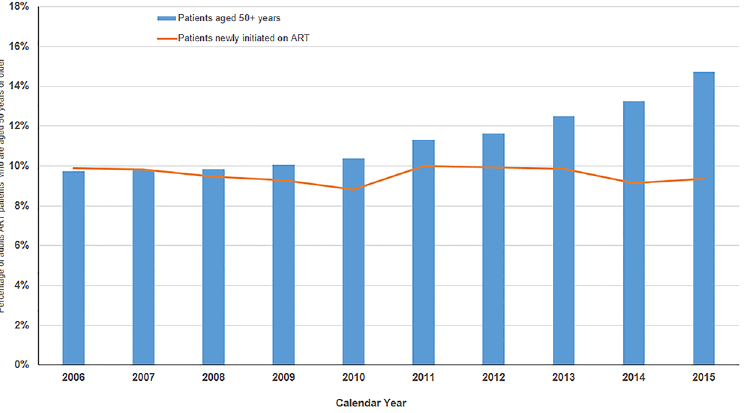
Fig 1. Proportion of older patients (50+years)receiving antiretroviral therapy (ART) at Martin Preuss and Lighthouse clinics between 2006 and 2015.